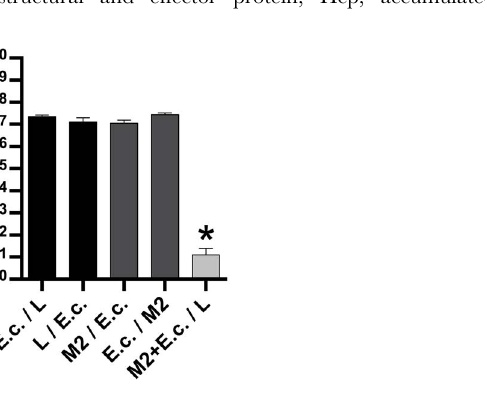
Figure 4. Acinetobacter baumannii out-competes E. coli in a contact dependent manner . Qualitative assessment of E. coli DH10B populations after 4 h of competition with the indicated A. baumannii strains or media. The backslash between strains (E.c.= E. coli , M2=strain M2) or L (L-broth) indicate the presence of a 0.22 m m pore filter. Data represent 3 biological replicates performed in duplicate. Error bars represent standard error of the mean of the biological replicates. * Indicates a significant difference ( P , 0.01) in E. coli CFU between the M2 + E.c./L group when compared to all other groups.